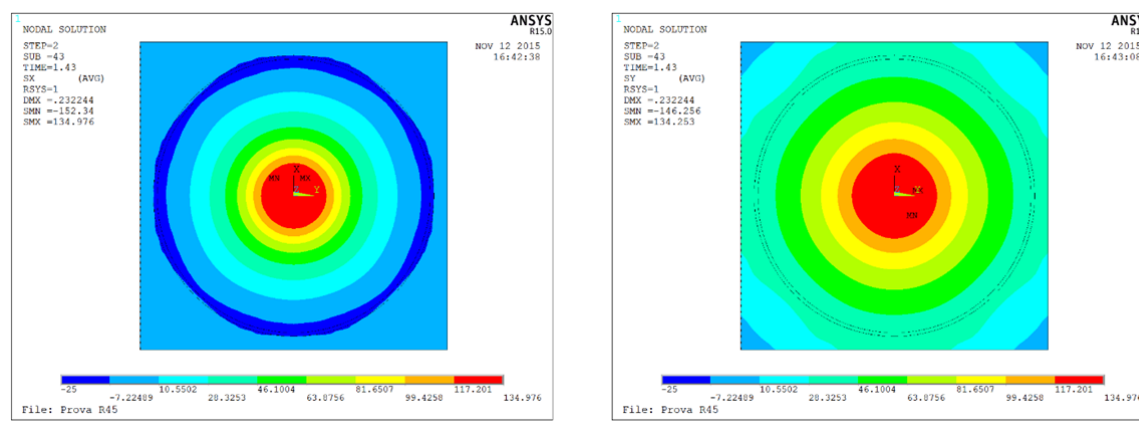
Fig. 3Facing-down surface: a) radial stresses; b) tangential